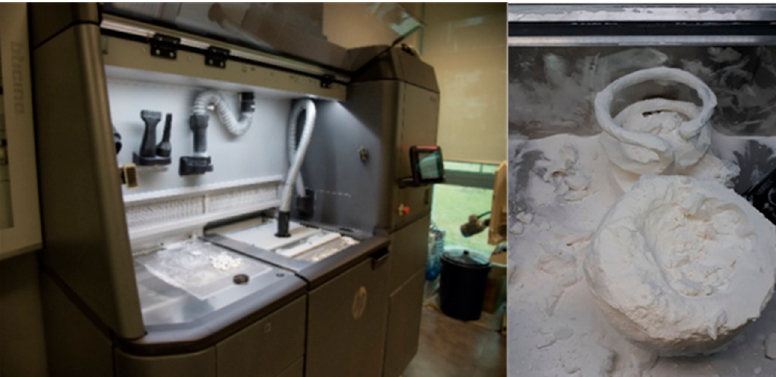
Figure 19. Processing station and material recovery .